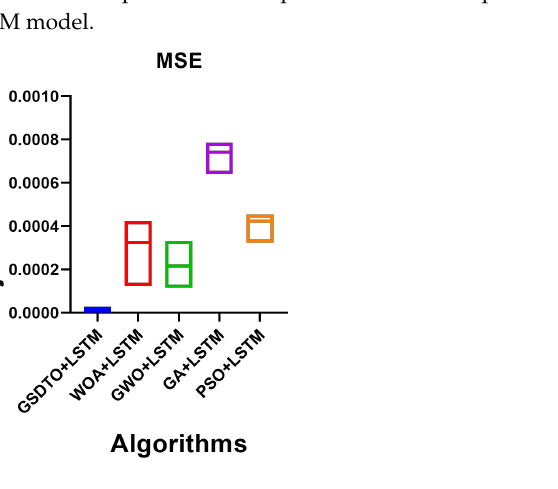
Figure 8. MSE for the presented and compared algorithms based LSTM model.